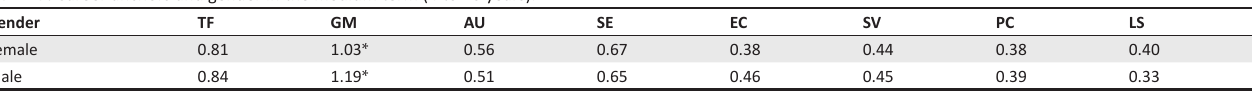
TABLE 7: Career anchors and gender in the medium term (4 to 10 years). Gender TF